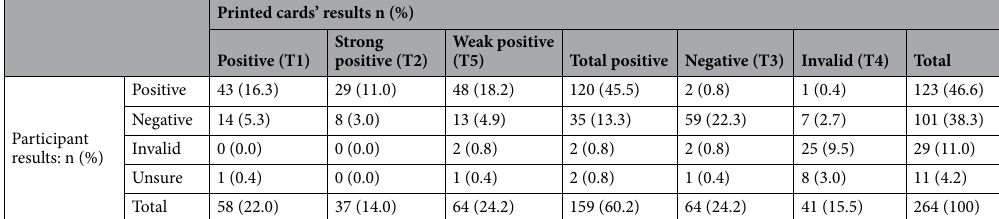
Printed cards’ results n